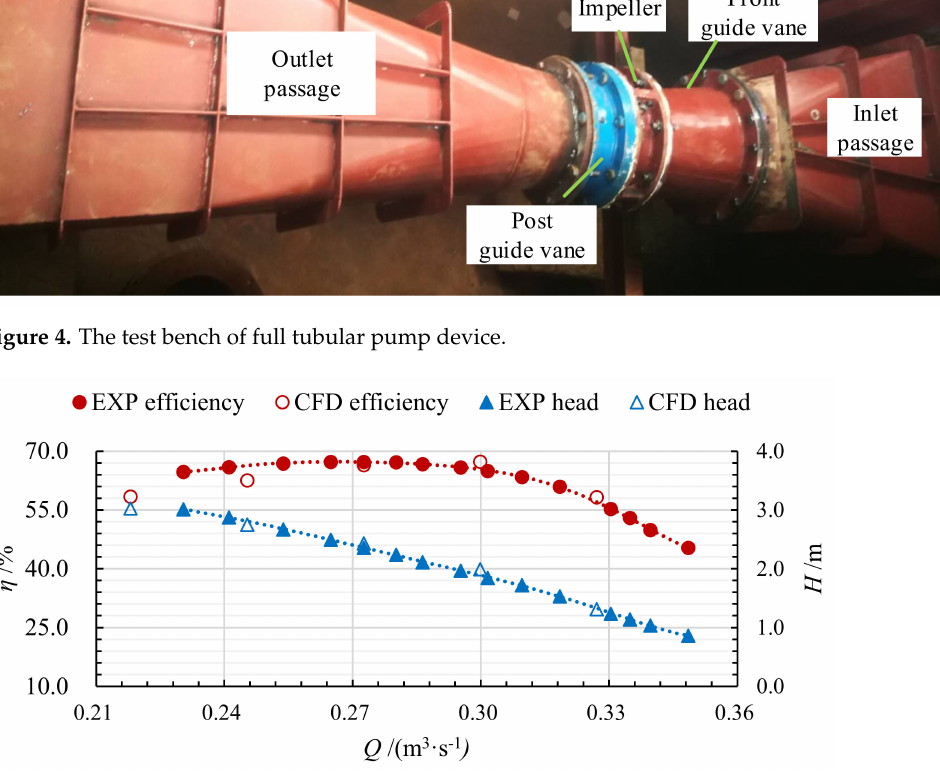
Figure 5. Comparison of experiment data and calculated results ( R b = 2